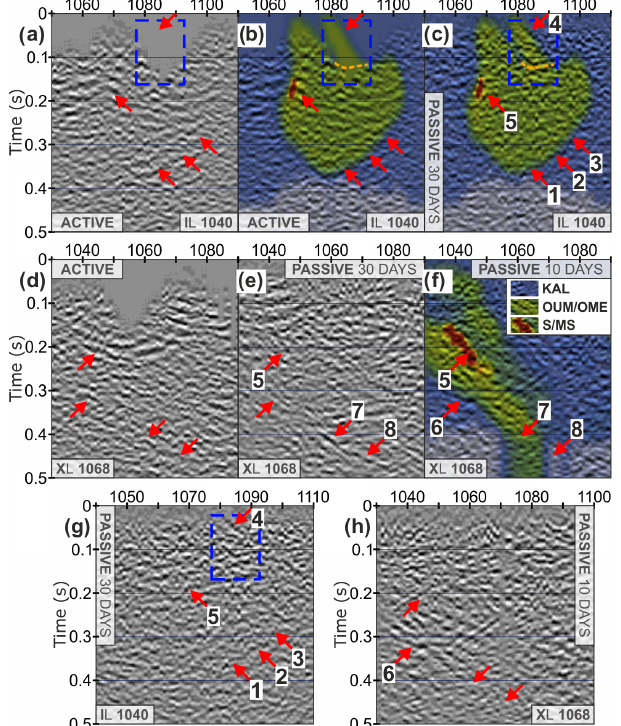
Figure 8. Comparison of post-stack migrated sections ob- tained from the active and passive surveys. Inline 1040 (a–c,g) and crossline 1068 (d–f,h) . (a–b,d) The active-source survey. (c,e,h) The 3D virtual-source survey. Red arrows mark the reflec- tion events that are associated with the contacts in the geological model and confirmed with the active-source data. The arrows with numbers show reflections that are interpreted in the text. The ge- ological model (described in Sect. 2) displayed in the background is color-coded as follows: S/MS mineralization (red); OUM/OME units (green); KAL unit (blue). Panels (g) – (h) show the same mi- grated stacks as in (c) and (f) , respectively, but without the geologi- cal model and with a broader spatial extent.